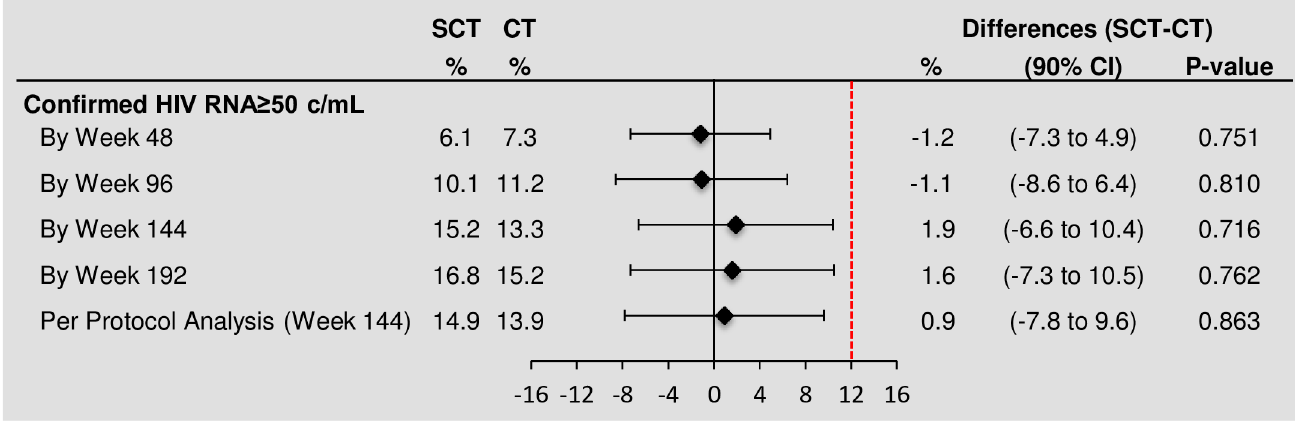
Fig 3. Confirmed HIV-1 RNA (cid:21) 50 copies/mL by 48, 96, 144 and 192 weeks. SCT = short cycle therapy, CT = continuous therapy.